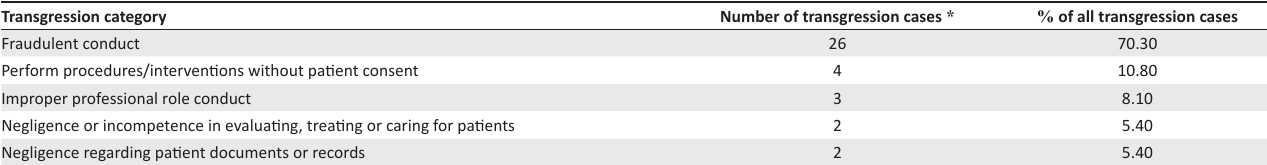
TABLE 4: Frequency of transgression categories linked to transgression cases.